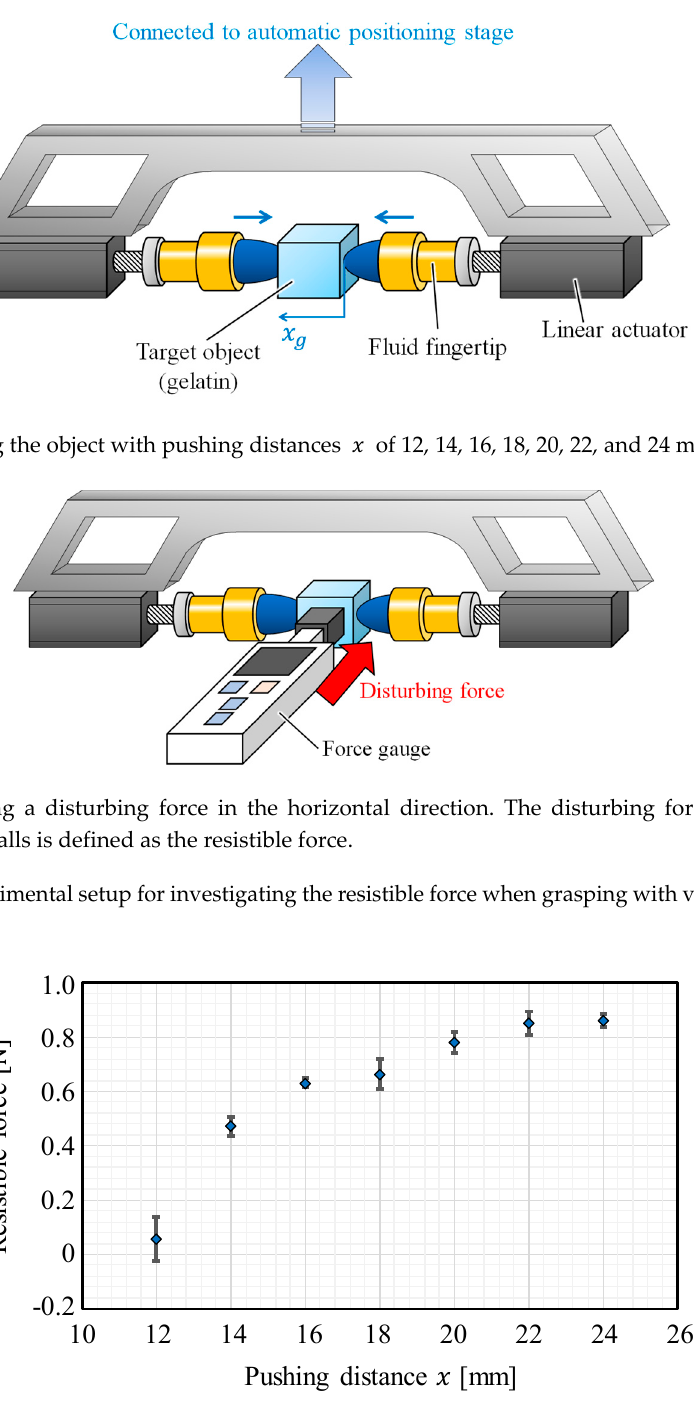
Figure 16. The resistible force when grasping with various degrees of compression: the average values and standard deviations are shown for each pushing distance.